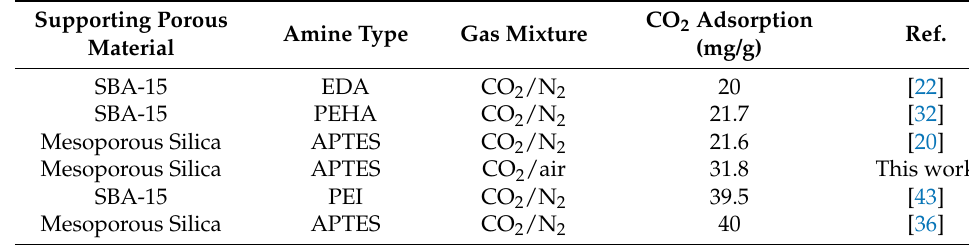
Table 7. Adsorption capacity of amine-modified silica from